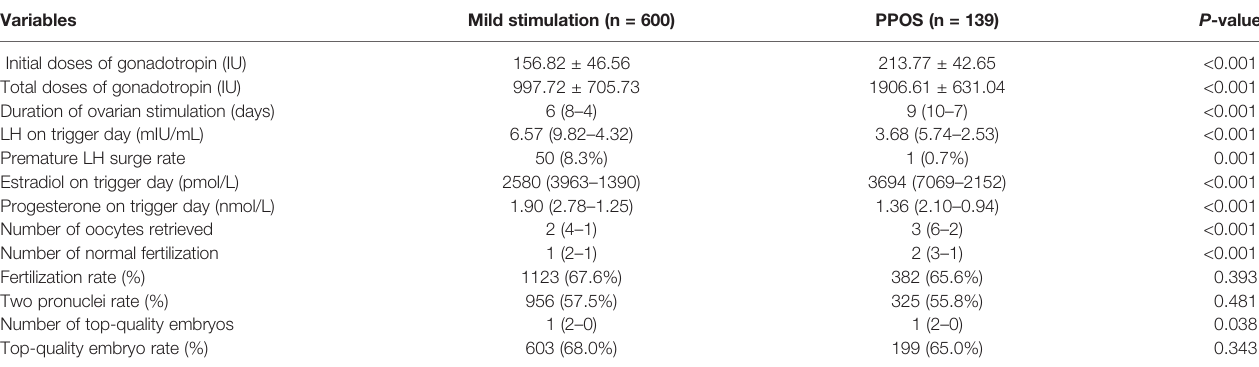
TABLE 2 | Characteristics of cycle parameters in both